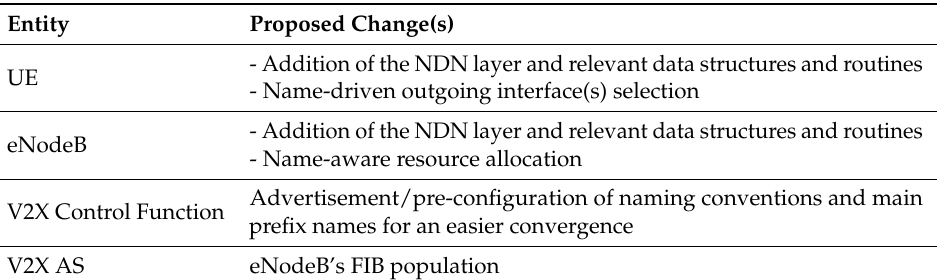
Table 4. Proposed changes and enhancements in the 3GPP V2X architecture. Entity Proposed Change(s)